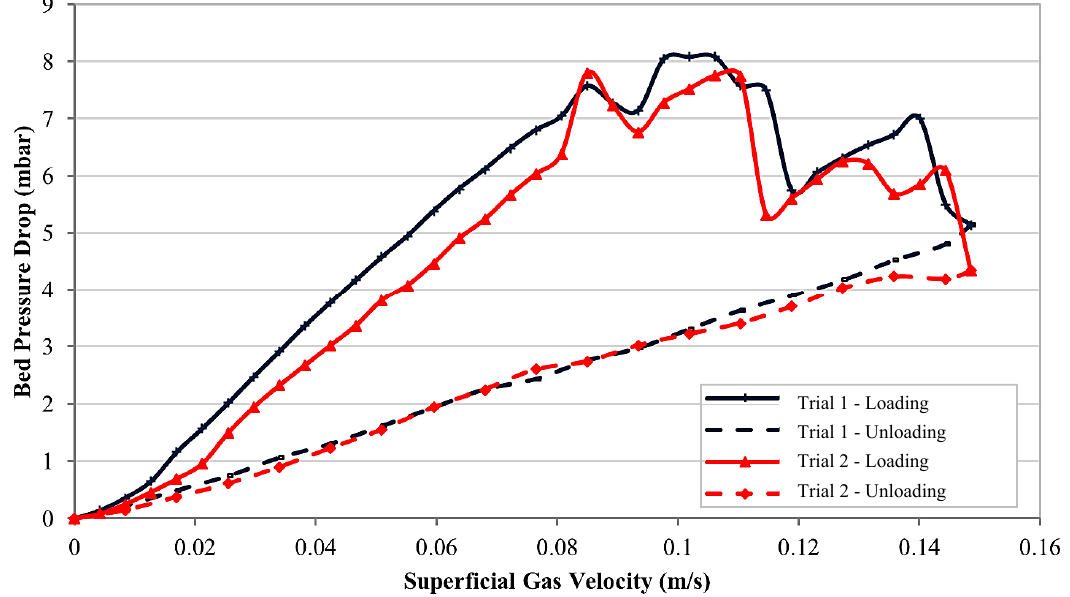
Figure 11. Two independent fluidization tests—loading (—) and unloading ( ‒ ‒ ) of mixed material—(68% of ultra-fine + 32% of fine particles).